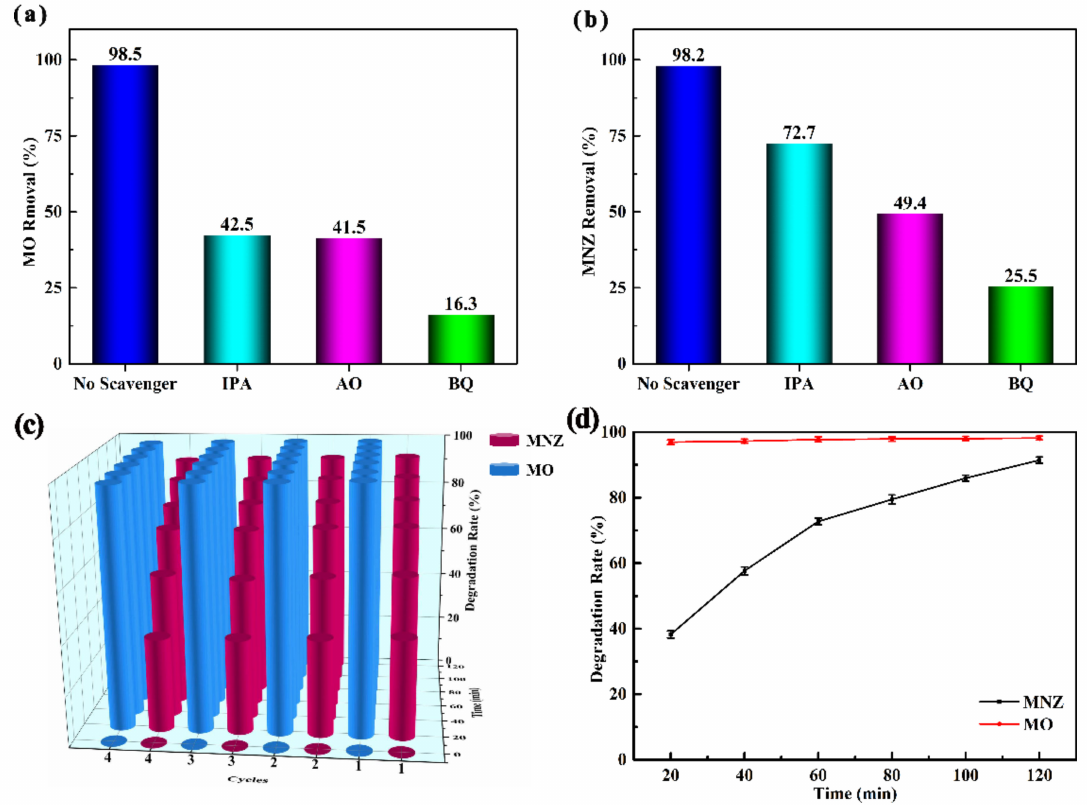
Figure 9. The effect of radical scavengers (IPA, AO, and BQ) on the degradation of MO ( a ) and MNZ ( b ). Photocatalytic degradation cycle ( c ) and parallel experiments ( d ) of